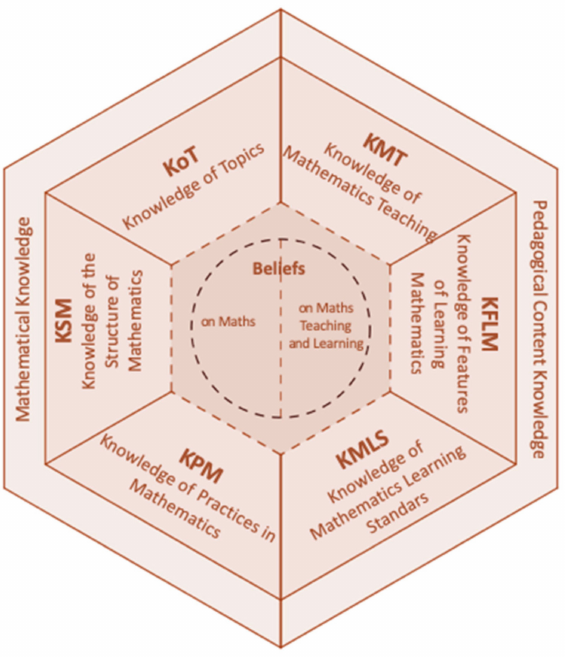
Figure 1. The MTSK model. Adapted with permission from Ref. [12] Copyright